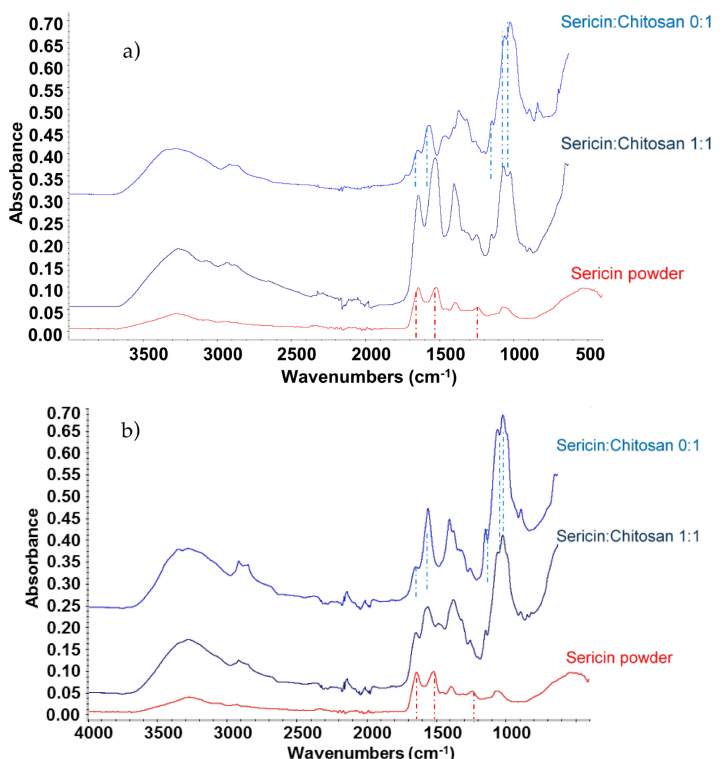
Figure 2. FTIR spectra at wave number during 400 to 4000 cm − 1 of ( a ) sericin-chitosan sca ff old with chitosan MW of 15,000 g / mol and ( b ) sericin-chitosan sca ff old with chitosan MW of 100,000 g / mol.